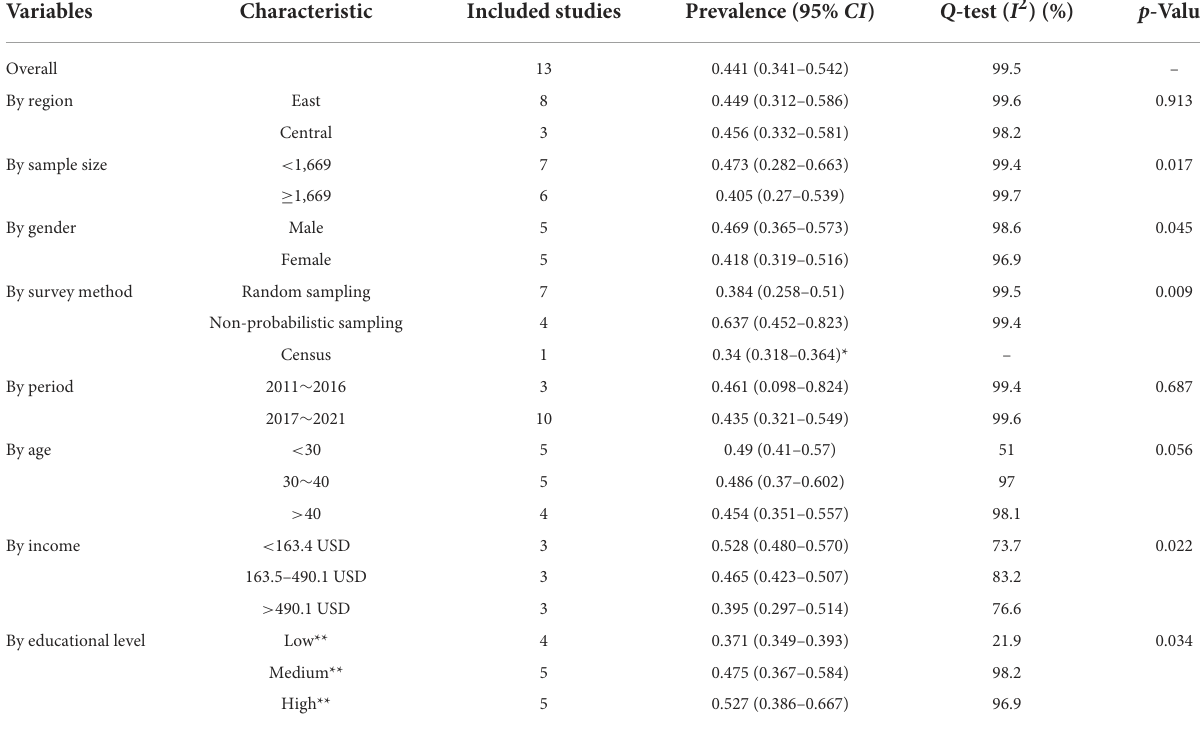
TABLE 5 Prevalence of turnover intention among VDs in